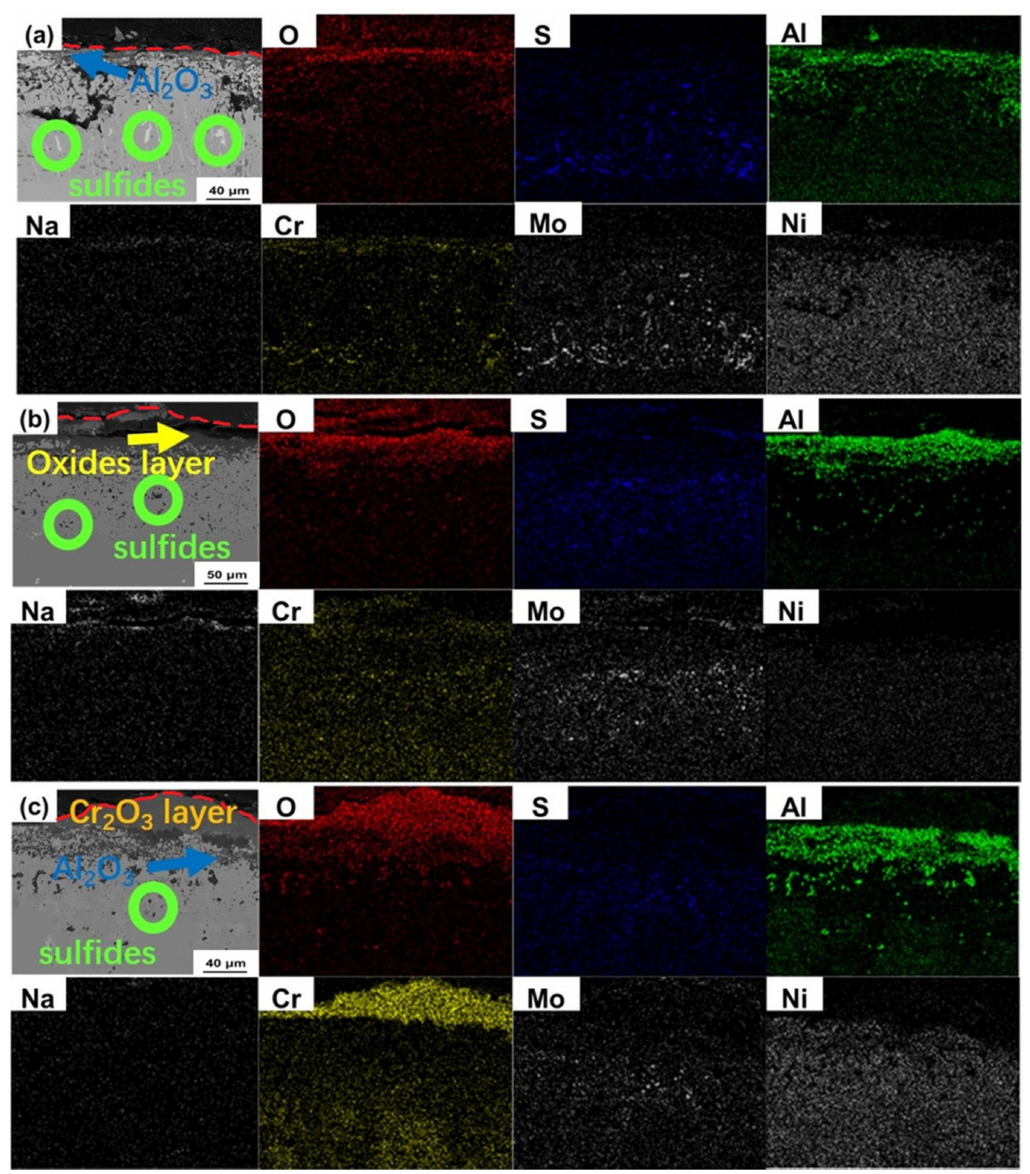
Figure 8. The cross-section morphologies and energy dispersive spectrometer (EDS) images of the unsealed corroded samples at 900 ◦ C for 200 h: ( a ) Alloy 1, ( b ) Alloy 2 and ( c ) Alloy